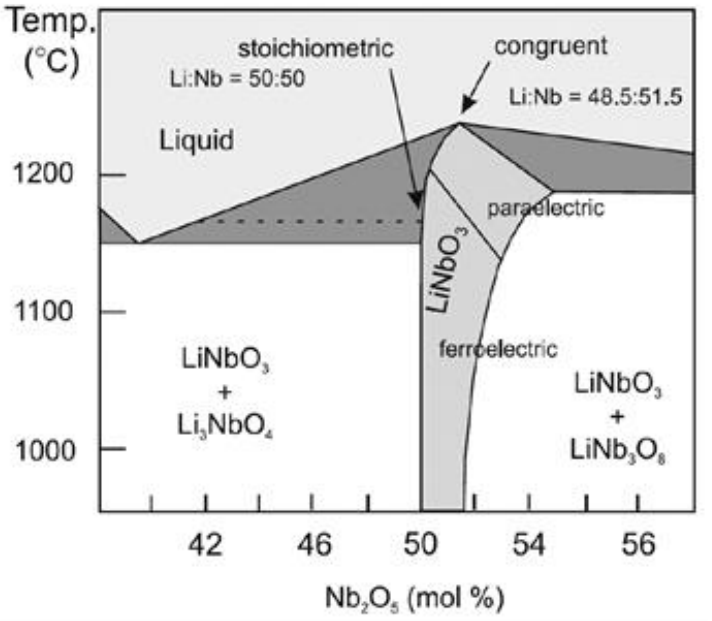
Figure 1. Phase diagram of a binary system Li 2 O-Nb 2 O 5 . Reprinted with permission from Ref. [1], 2008, Springer.